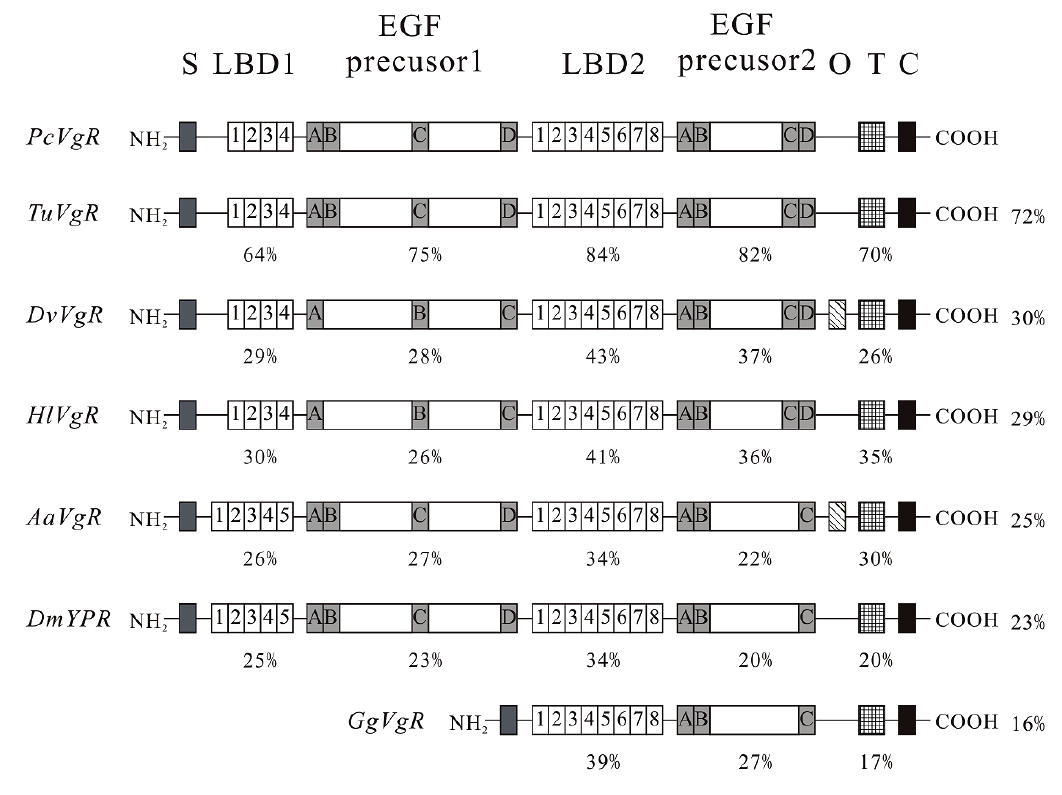
Figure 2. Schematic comparison of the primary protein structures of Panonychus citri vitellogenin receptor ( PcVgR ) with those of other arthropod species. The cysteine-rich repeats in the ligand binding domains (LBDs) are shown with numbers 1–8. The cysteine-rich repeats in the epidermal growth factor (EGF)-precursor domains are indicated with letters A–D. The percentage identity compared with PcVgR in a specific domain is shown. The ratio (%) on the right side indicates the overall identity as compared with PcVgR . S, signal peptide; O, O -linked sugar domain; T, transmembrane region; C, cytoplasmic tail. Sequences were taken from the Tetranychus urticae genome and GenBank database (accession ID or No. in parentheses): TuVgR , T. urticae (tetur27g01310); DvVgR , Dermacentor variabilis (DQ103506); HlVgR , Haemaphysalis longicornis (AB299015); AaVgR , (DMU13637); and GgVgR , Gallus gallus